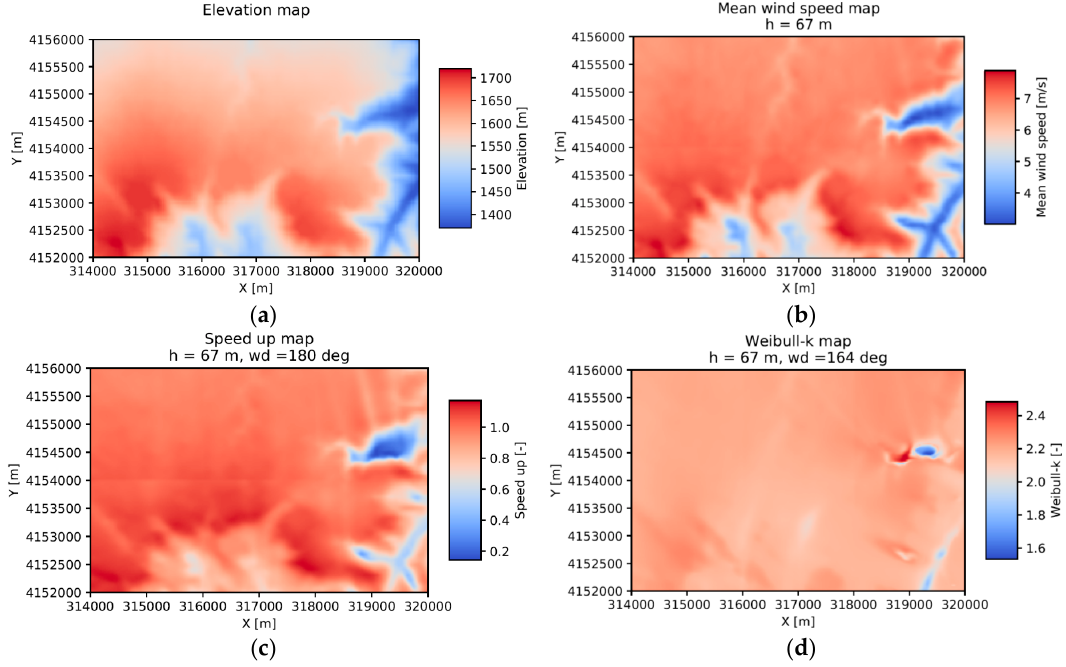
Figure 1. Interpolated site condition variables for a wind farm site in complex terrain: ( a ) elevation; ( b ) mean wind speed at 67 m height above the ground; ( c ) speed up at 67 m height under the far field inflow wind direction of 180°; ( d ) Weibull-k at 67 m height under the far field inflow wind direction of 164°.